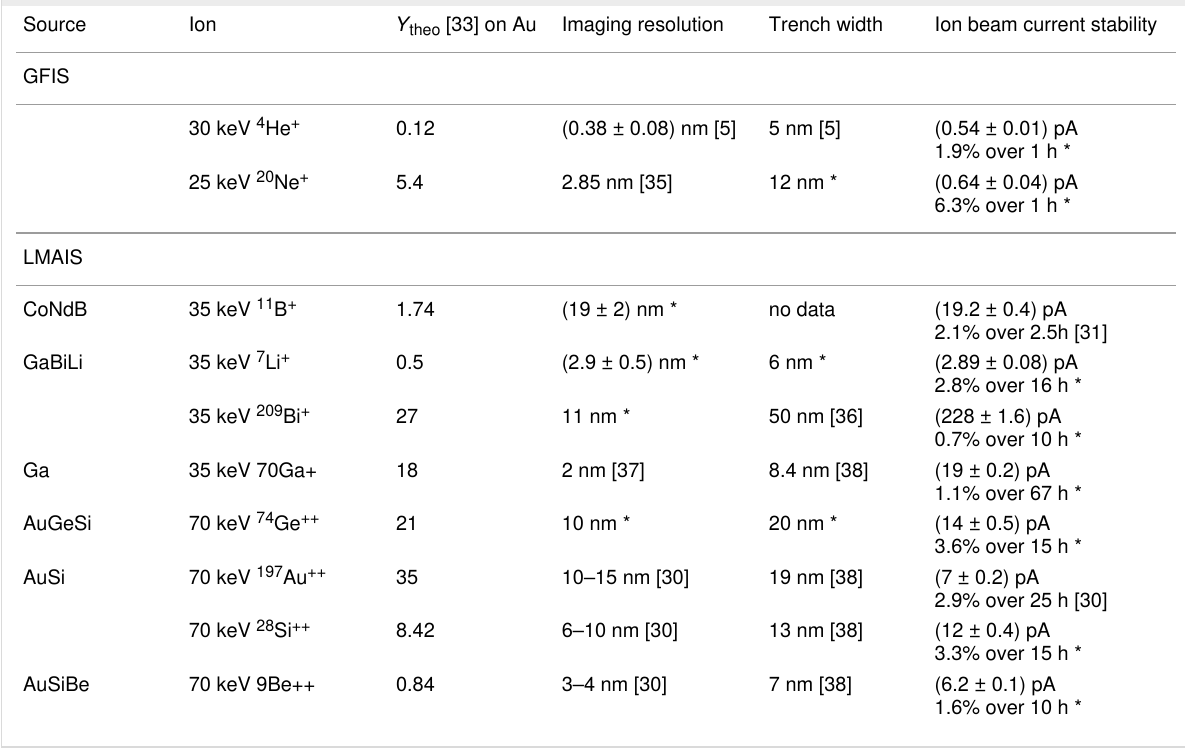
Table 2: Irradiation parameters for several available ions, calculated sputter yields Y theo [34] of Au, imaging resolution (80/20 criterion), the smallest achieved milling trench width and typical ion beam currents as well as their stability logged over several hours. Literature values are indicated by their reference, data from this work is marked by an